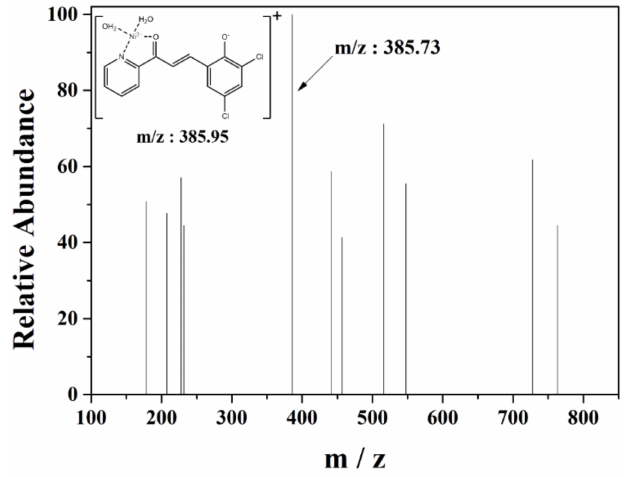
Figure 4. Positive-ion mass spectrum of DPP (1 × 10 − 5 M) with Ni(NO 3 ) 2 (1.0 eq.).